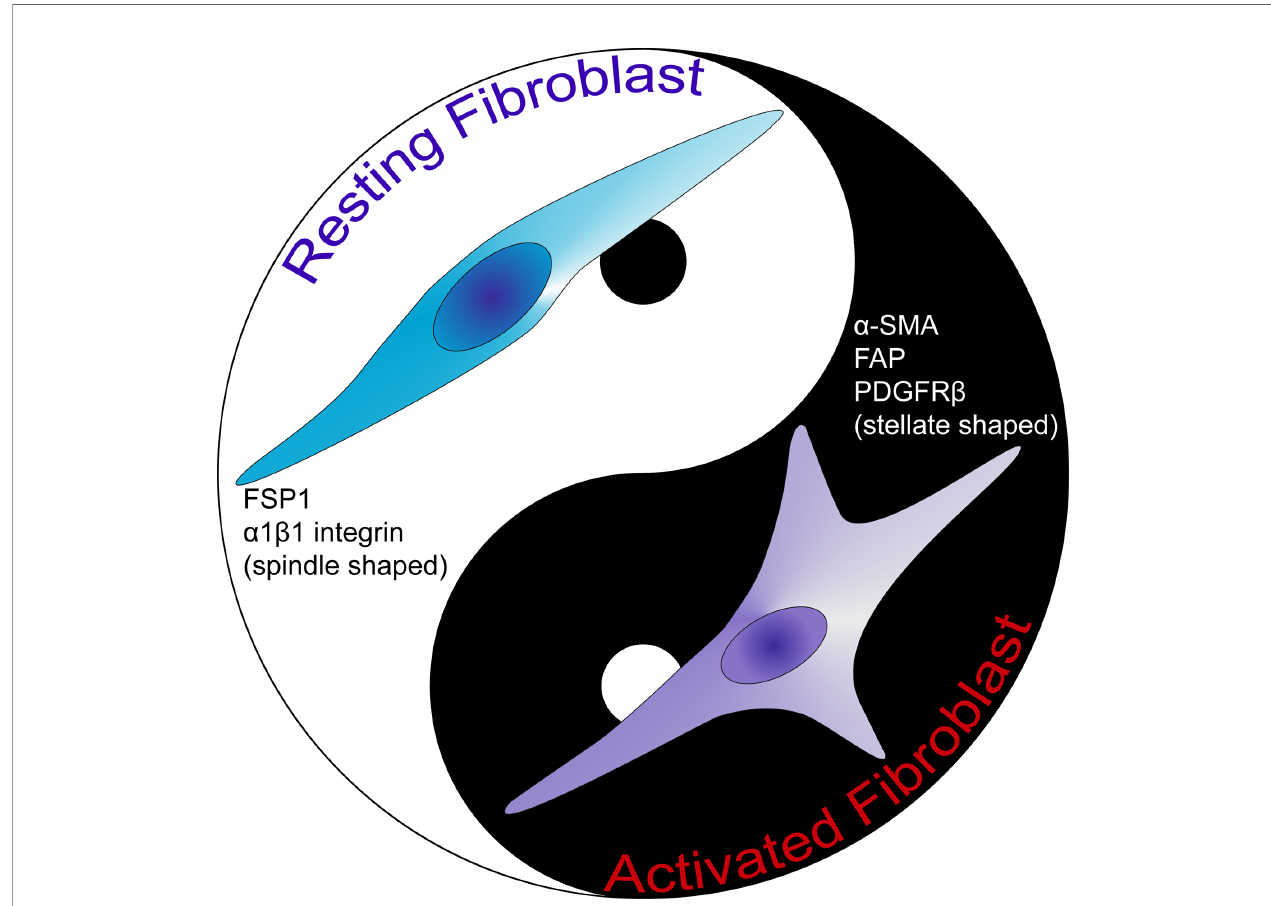
FIGURE 2 | The comparison of activated fi broblast and resting fi broblast cells. Resting fi broblast cells are morphologically spindle shaped in contrast to activated fi broblast cells which are stellate shaped. Activated fi broblast cells express a -SMA, FAP and PDGFR b . FAP, fi broblast activation protein; FSP1, fi broblast-speci fi c protein 1; PDGFR b , platelet-derived growth factor receptor- b ; a -SMA, a -smooth muscle